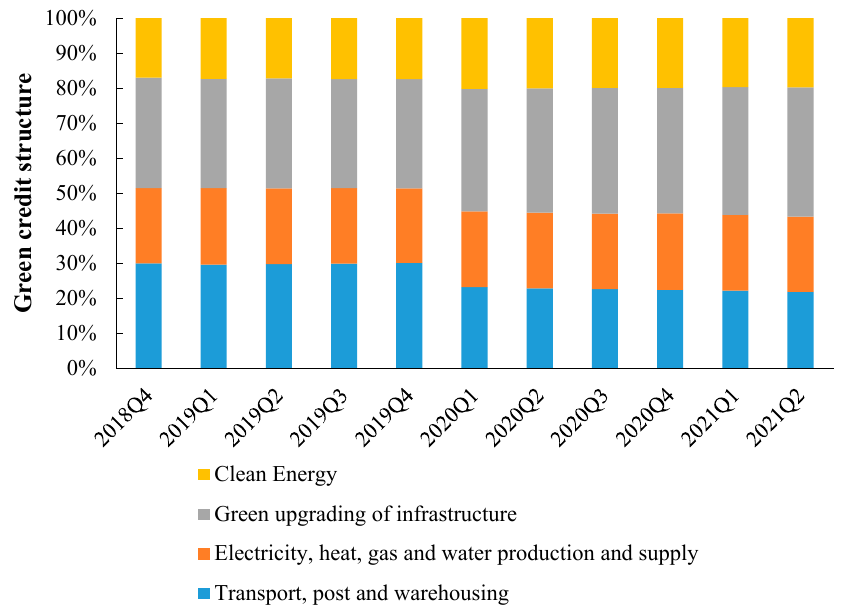
Figure 2. Sector structure of green credit in China, 2018–2021. Note: Data are from China Development Bank.